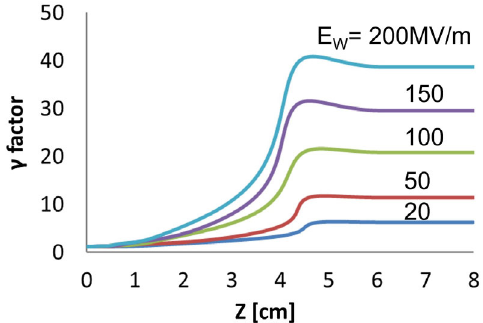
FIG. 2. Increase in relativistic energy factor γ of nonreflected electrons in an eCRA cavity with R ¼ 6 . 0 cm, and L ¼ 6 . 113 cm, for the indicated values of maximum rf electric field at the wall E . The electrons enter at x ¼ y ¼ z ¼ 0 , with w initial kinetic energy 100 keV. Energy gain is seen to be mainly in the ∼ 3 -cm central region of the cavity where the E -fields are strongest; but the nominal acceleration gradient values we cite are equal to the energy gain divided by the full cavity length. See Table II for other parameters.